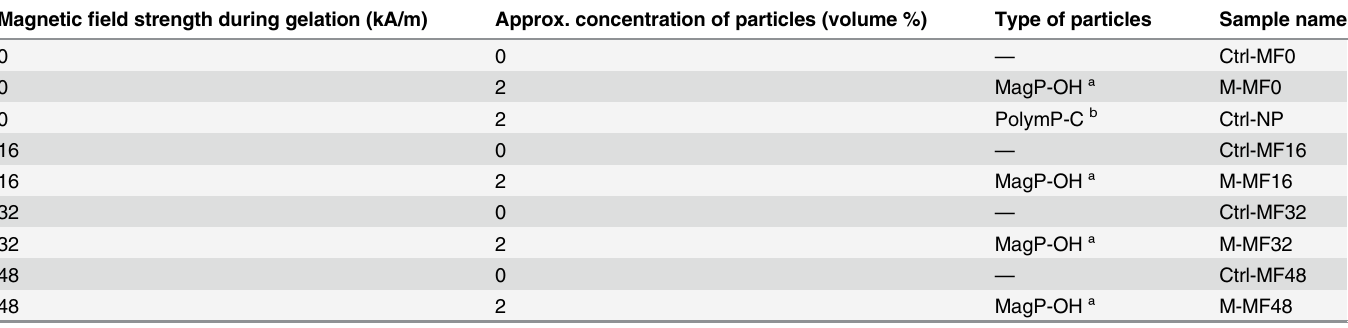
Table 1. Summary of the different oral mucosa substitutes prepared for this study. Magnetic fi eld strength during gelation